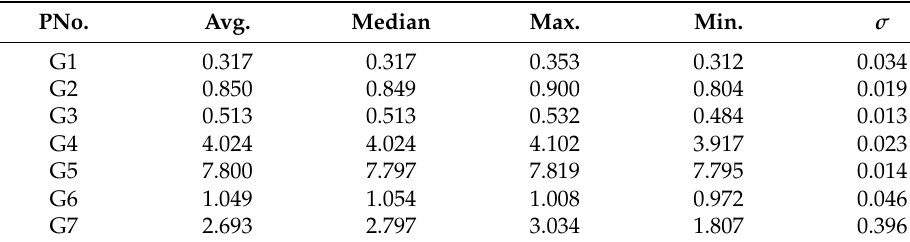
Table 2. Adjusted UWB-only positioning error statistics (m).